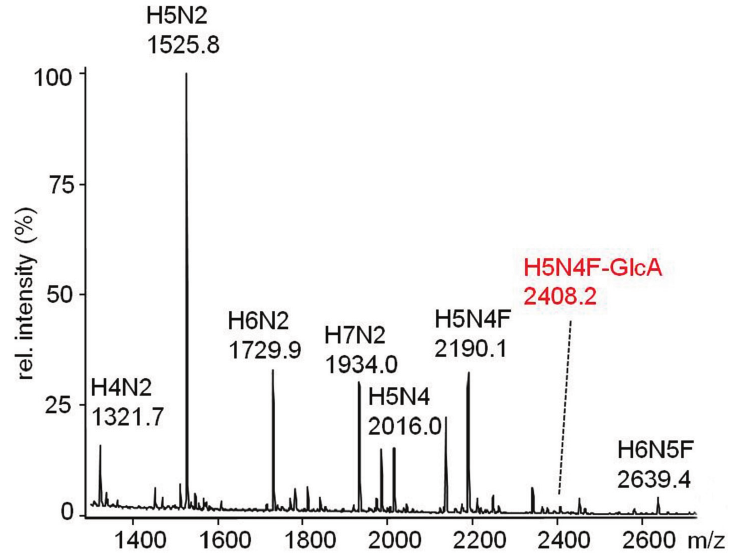
Figure 11. MALDI-MS spectrum of the permethylated N -glycans of Nid1, coexpressed with dGlcAT-S in CHO-Lec2 cells. The signals were detected as molecular ions M+Na + -54, corresponding to a loss of sodium-methylate. The non-sulfated HNK1-epitope carrying glycan (H5N4F-GlcA) was detected at m / z 2408. The structure was verified by MS/MS. Short notation of glycan structures: H, hexose; N, N -acetylhexosamine; F, fucose; GlcA, glucuronic acid.